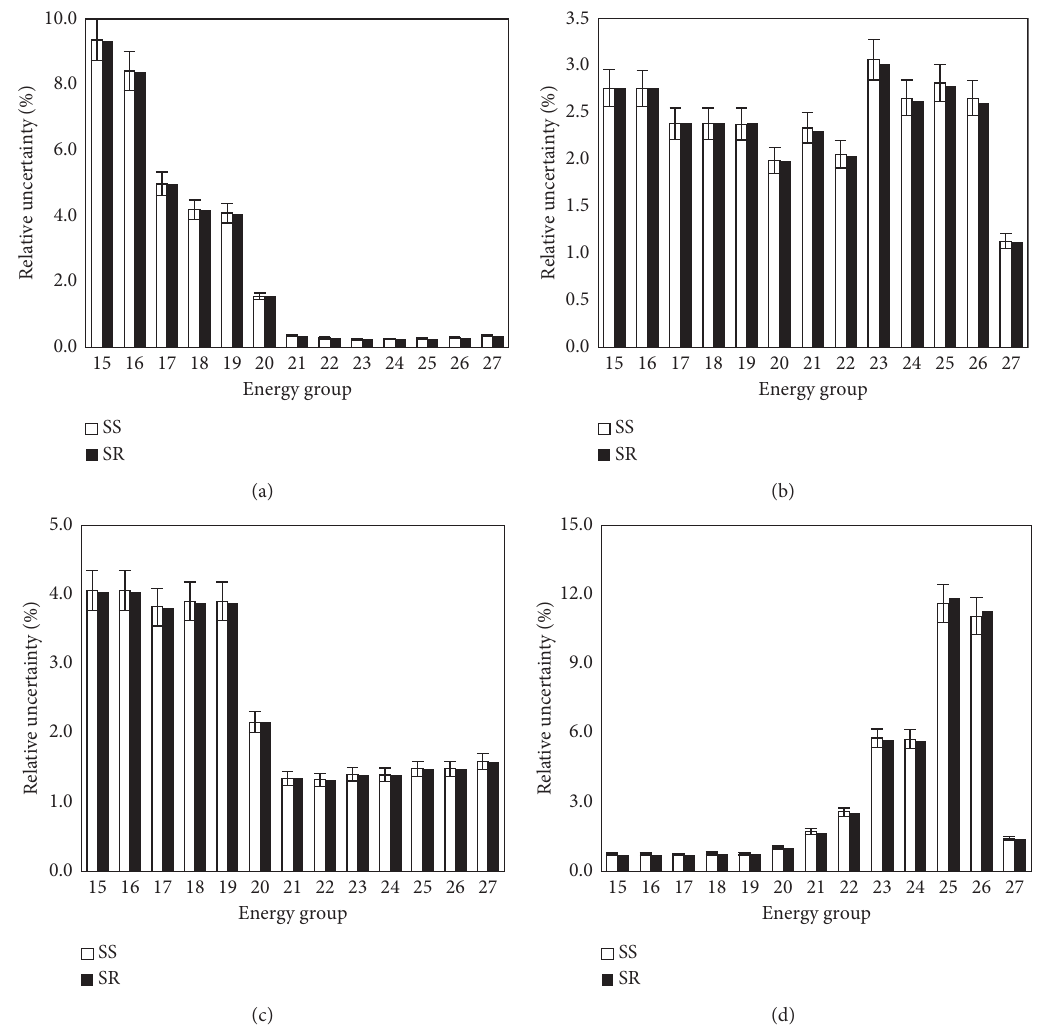
Figure 11: The uncertainty of effective resonance self-shielding cross sections. (a) 235 U effective resonance absorption XS. (b) 238 U effective resonance absorption XS. (c) 235 U effective resonance scattering XS. (d) 238 U effective resonance scattering XS.